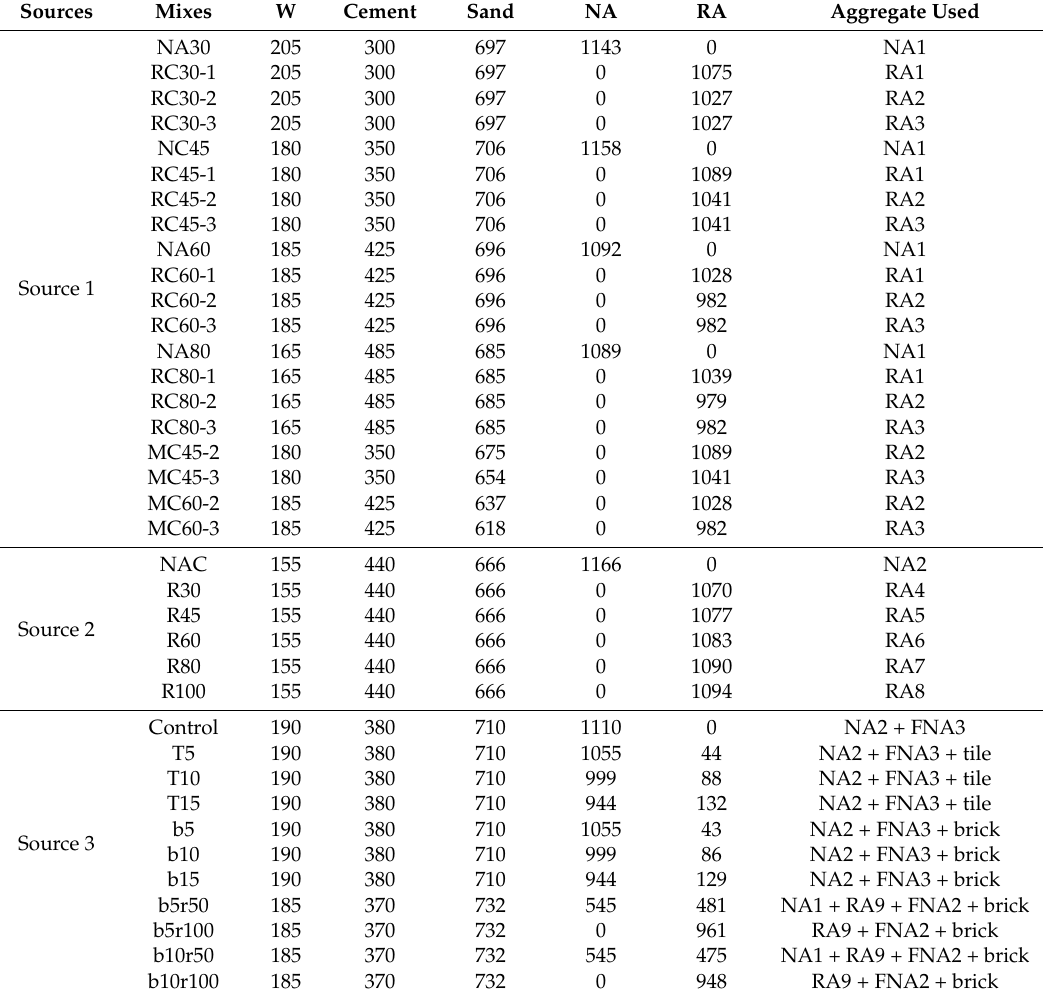
Table 2. Mix proportions of recycled aggregate concrete (RAC) made with aggregates from different sources (kg/m 3